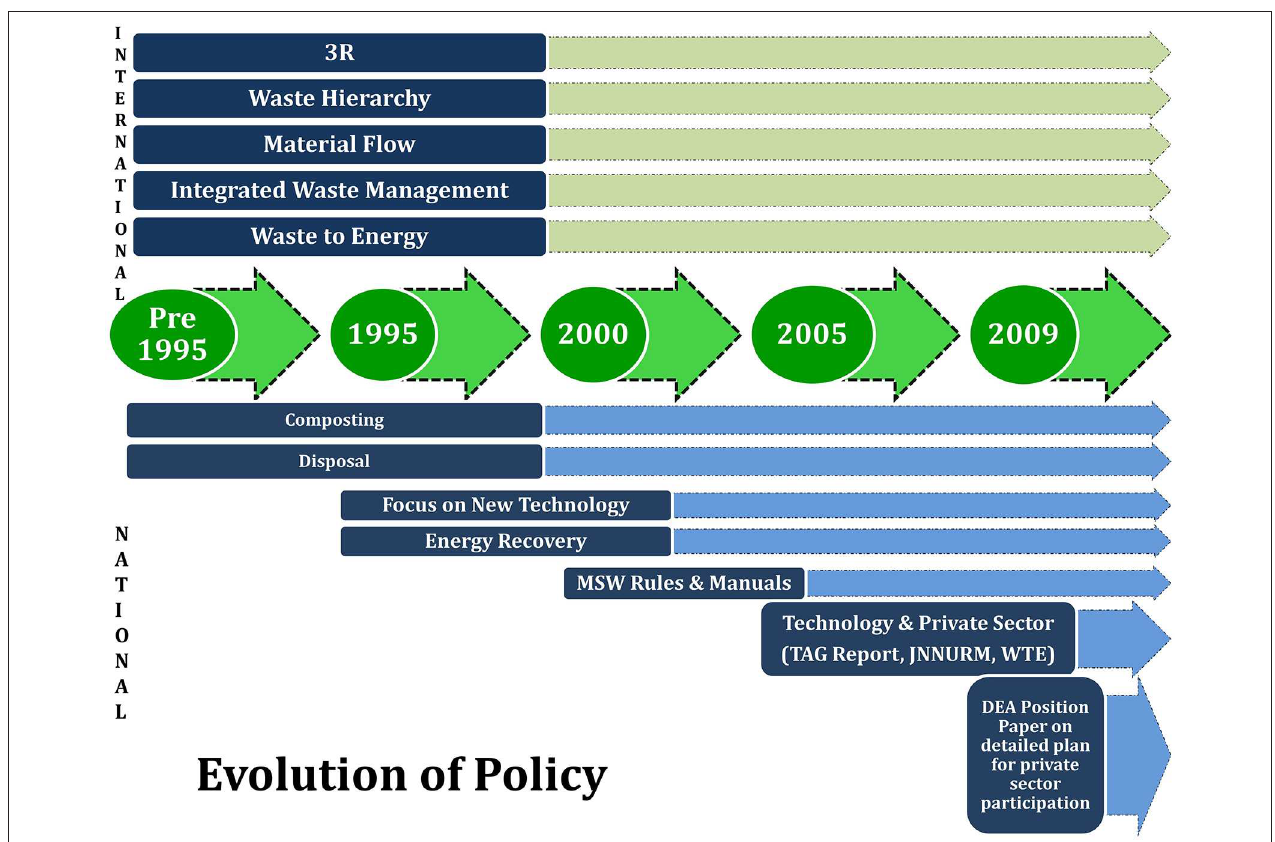
FIGURE 1 | Evolution of waste management policy in